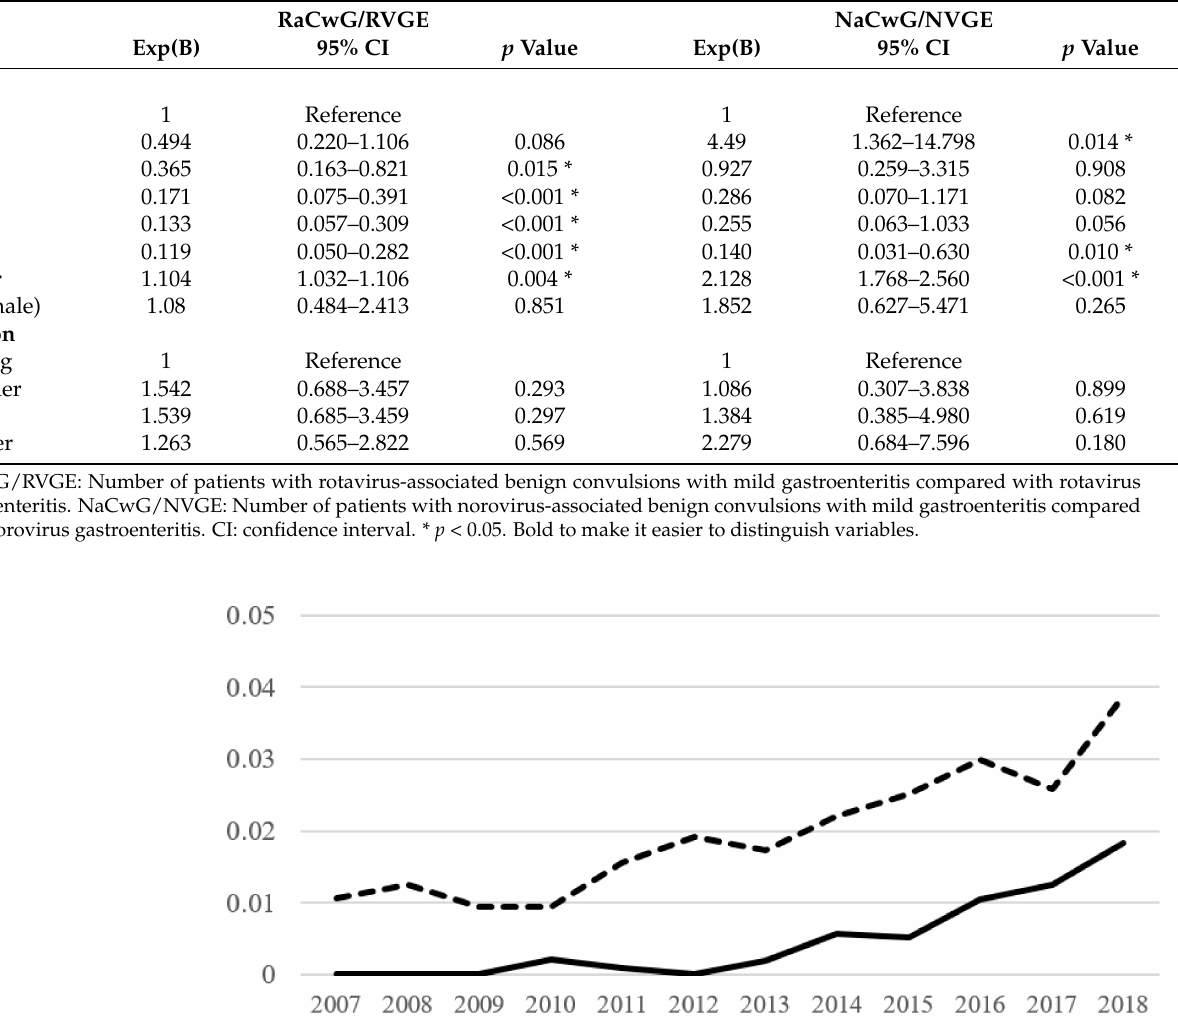
Table 4. Negative binomial regression analysis of the patients with RaCwG compared with RVGE; the patients with NaCwG compared with NVGE.